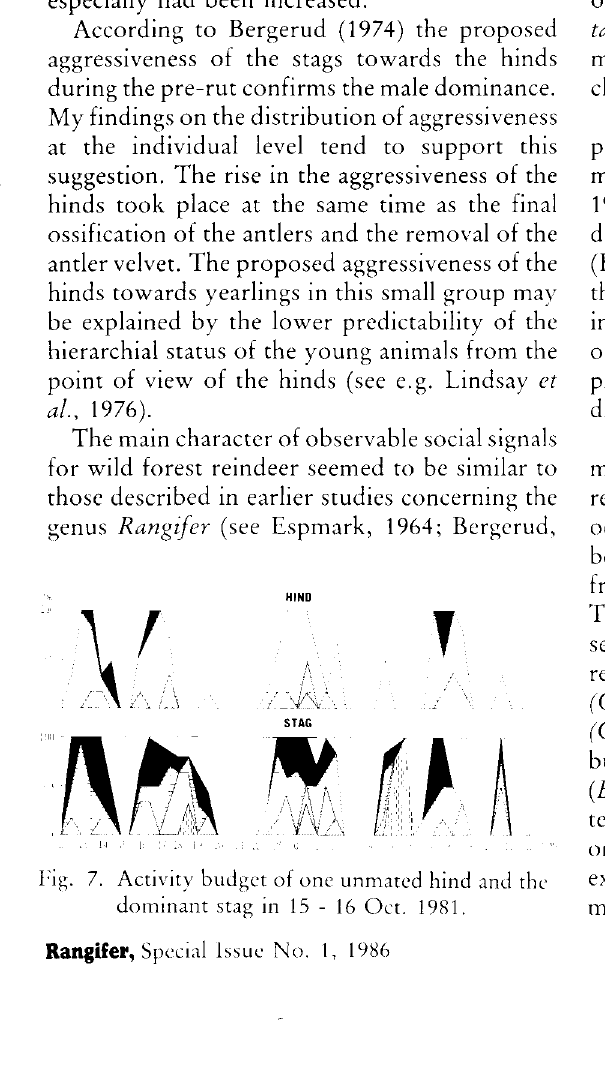
Fig. 6. Activity budget of the harem in 18 - 19 Sept. 1981.